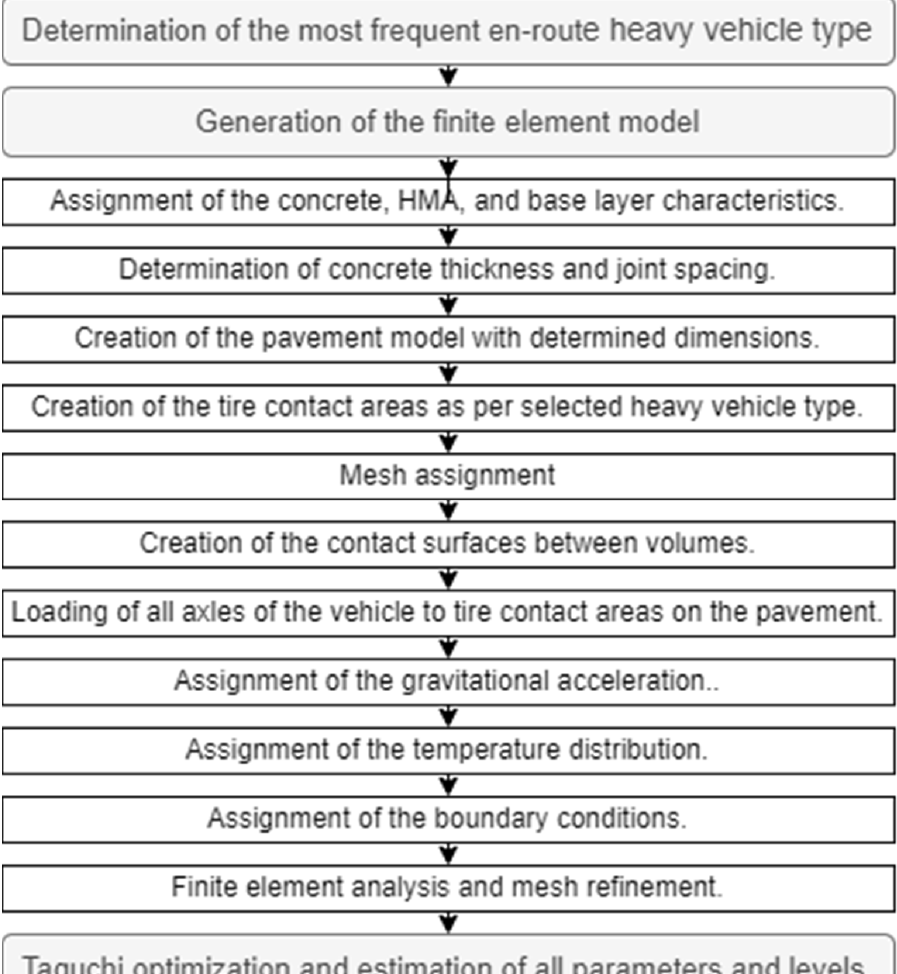
Figure 10. Steps of the finite element analyses.